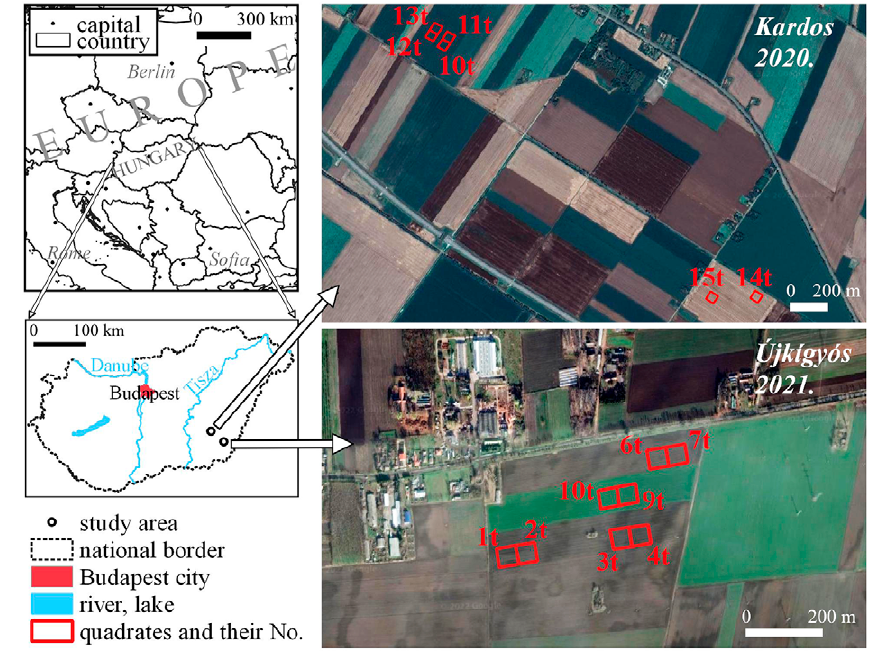
Figure 1. Sample quadrates near Kardos (No. 10t-15t) and Újkígyós settlements (No. 1t-4t, 6t-7t, 9t-10t) located on